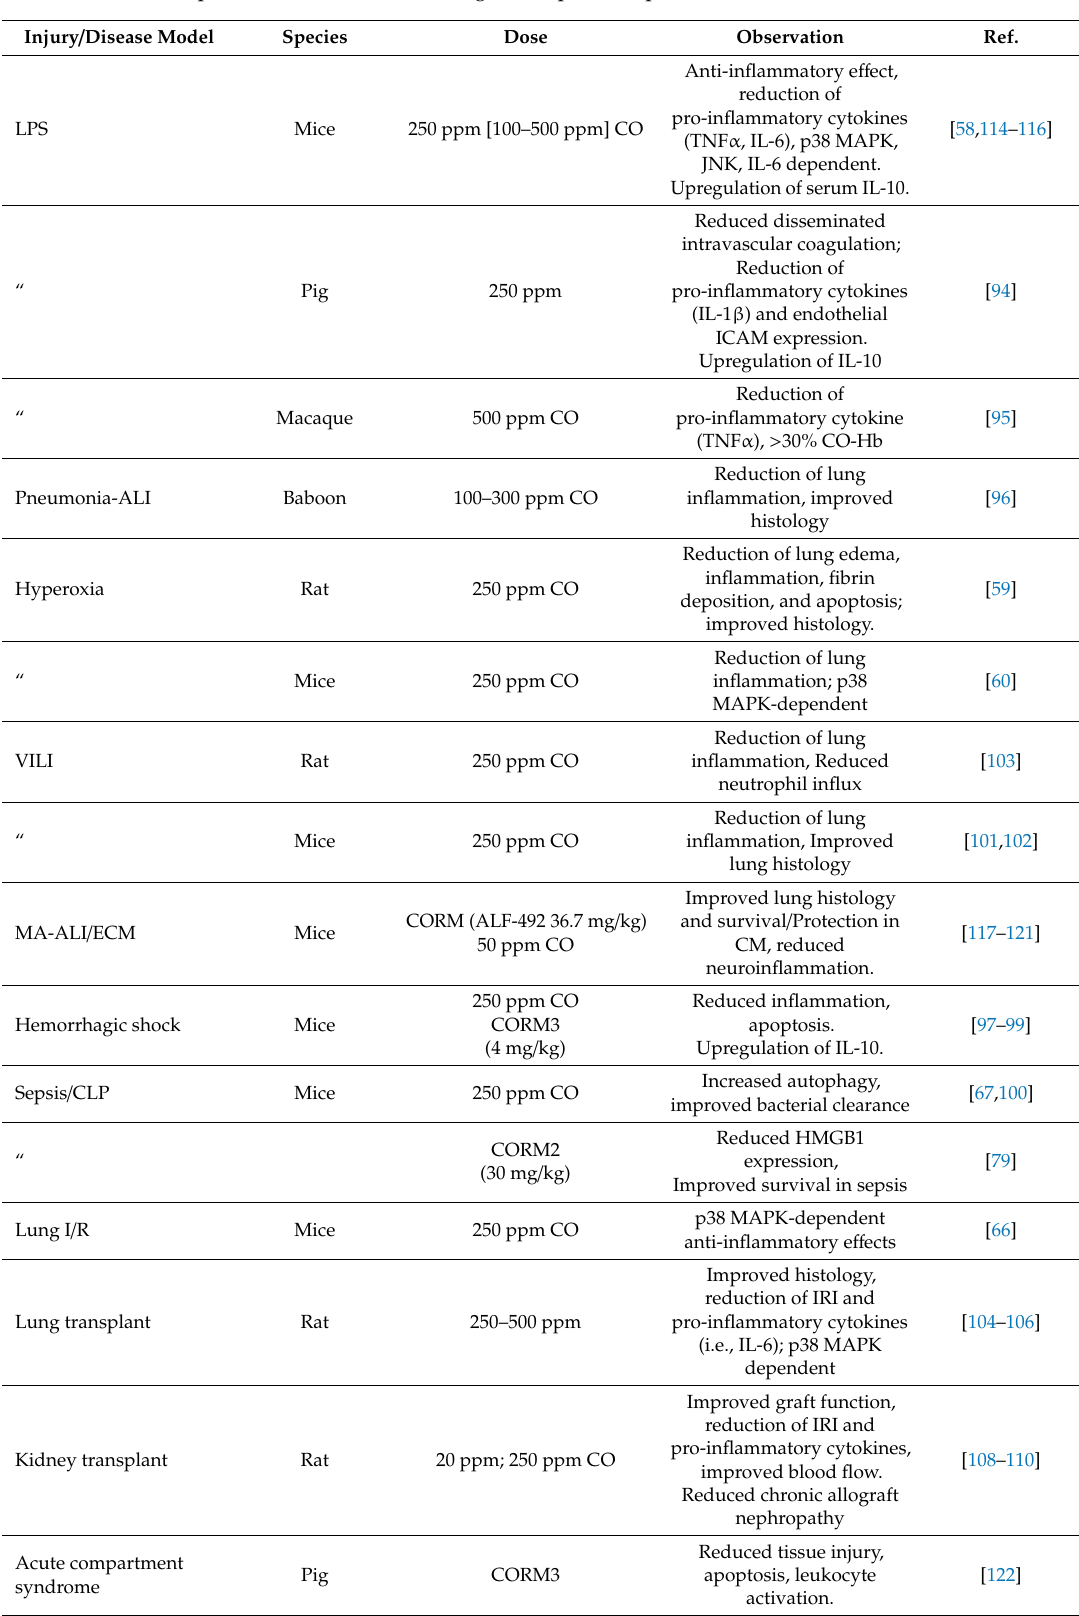
Table 2. Representative studies showing CO-dependent protection in inflammation models. Injury / Disease